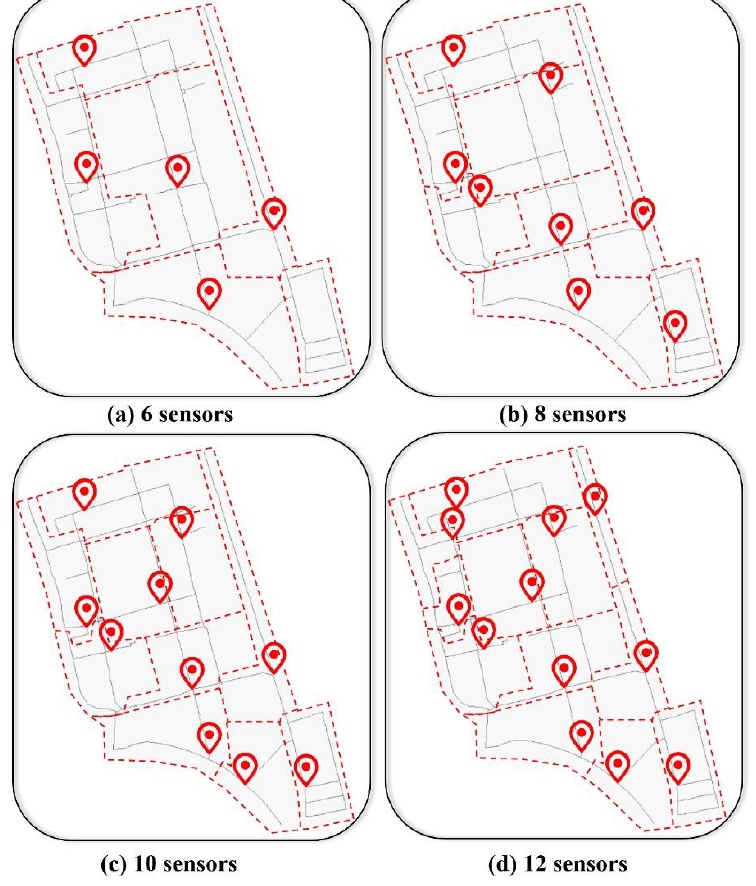
Figure 7. Pressure sensor arrangement using SDCN method.